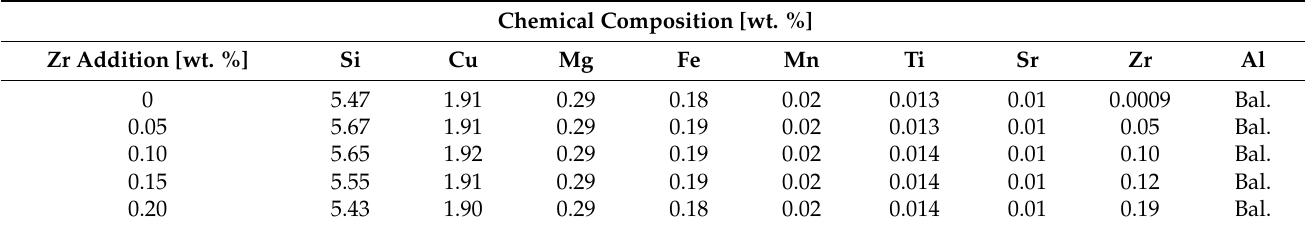
Table 2. Chemical composition of the experimental alloys AlSi5Cu2MgZrX.